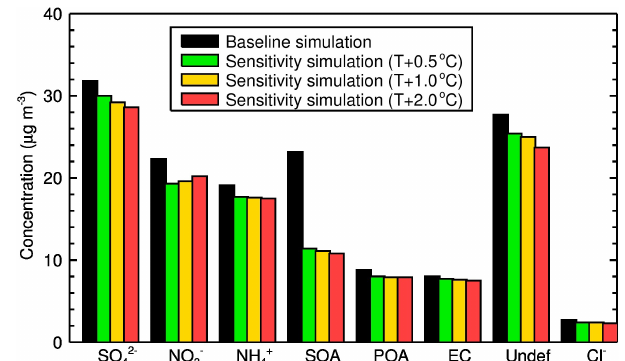
Figure 6. Comparisons of PM 2 . 5 chemical composition in the Sichuan Basin between the baseline simulation (black) and sensi- tivity simulations that the plateau warms by 0.5 ◦ C (green), 1.0 ◦ C (yellow) and 2.0 ◦ C